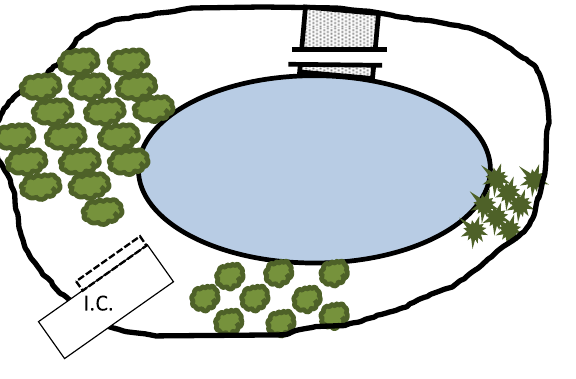
FIG. 6. School yard with two narrow bridges, in parallel, over the